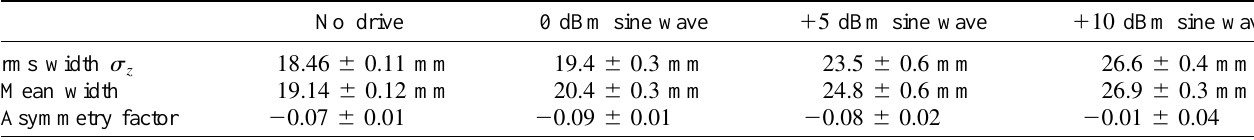
TABLE VI. The bunch length and asymmetry factor when the amplitude of the rf voltage is modulated at a frequency of 349.9